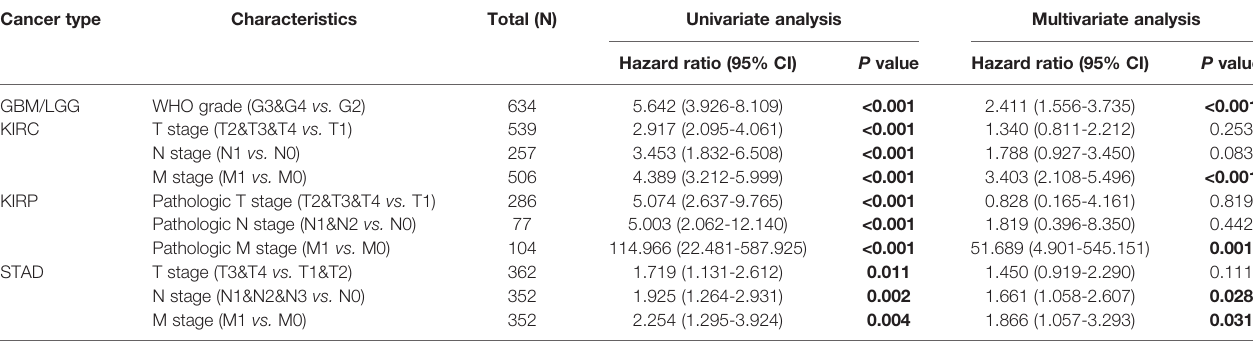
TABLE 2 | Univariate and multivariate analyses of overall survival.